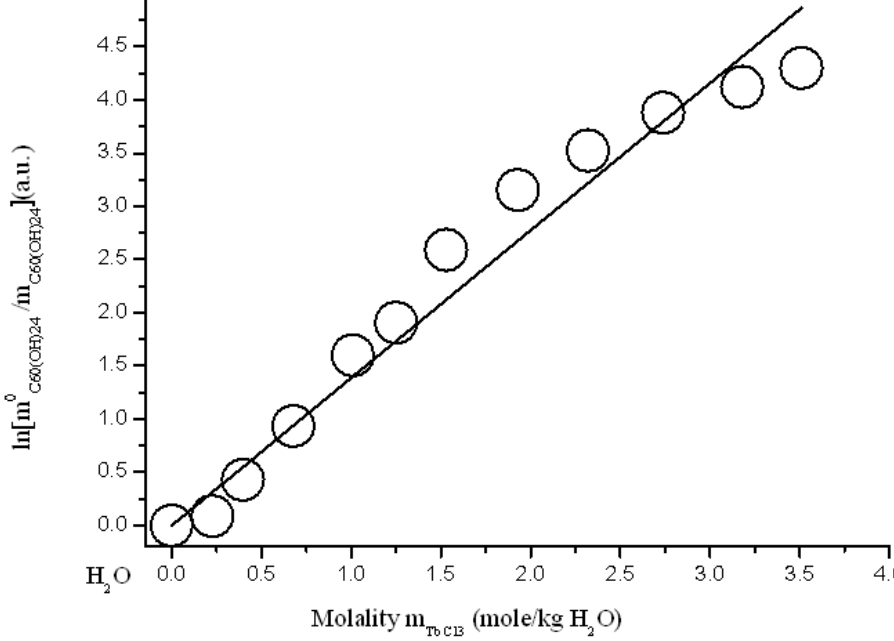
Figure 14. Branch of crystallization С 60 (ОН) 24 *18Н 2 О in the diagram of solubility in ternary system С 60 (ОН) 24 —TbCl 3 —